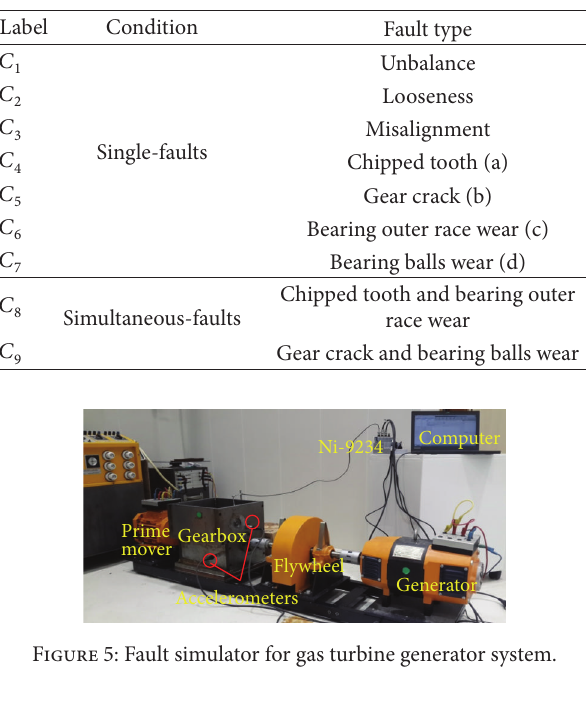
Table 1: Description of each fault condition of the gearbox.